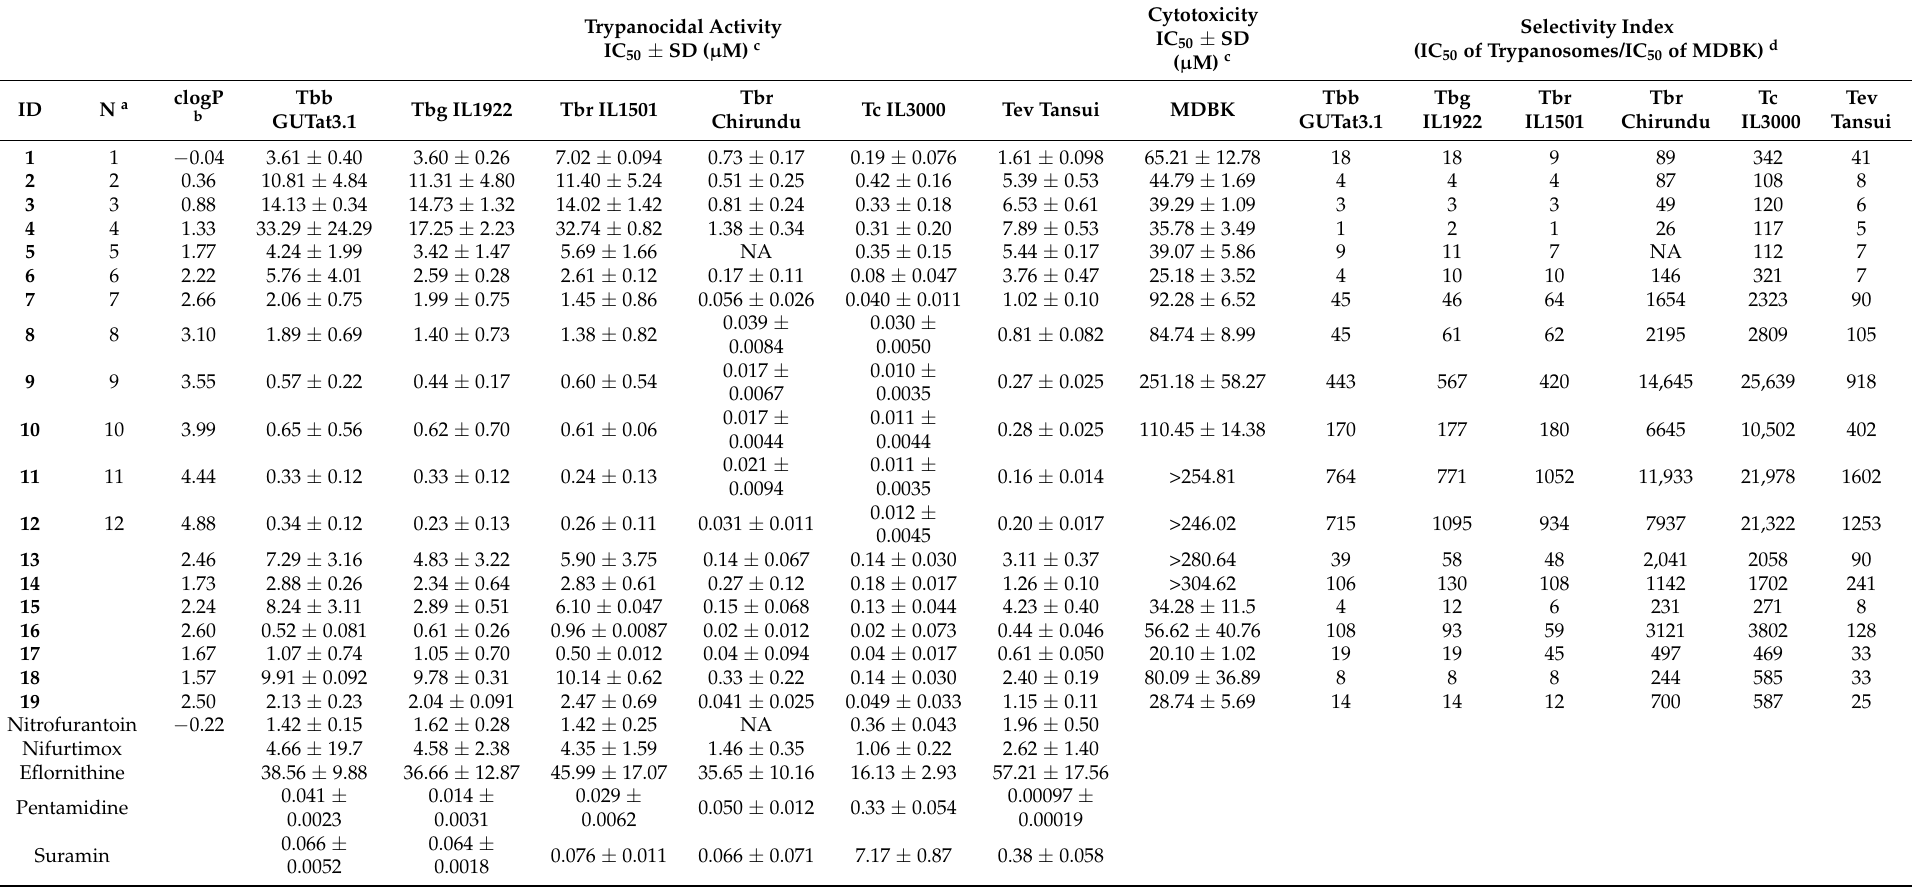
Table 2. In vitro biological activities of synthesized nitrofurantoin